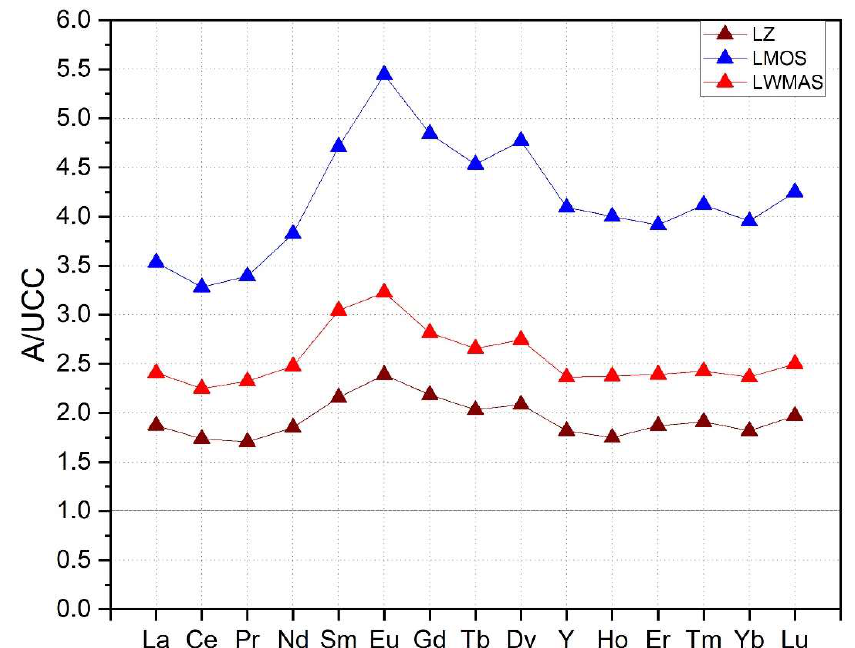
Figure 9. Distribution of REY content in the tested fly ash. The share of REY was normalized to their content in the upper continental crust (UCC) [15].